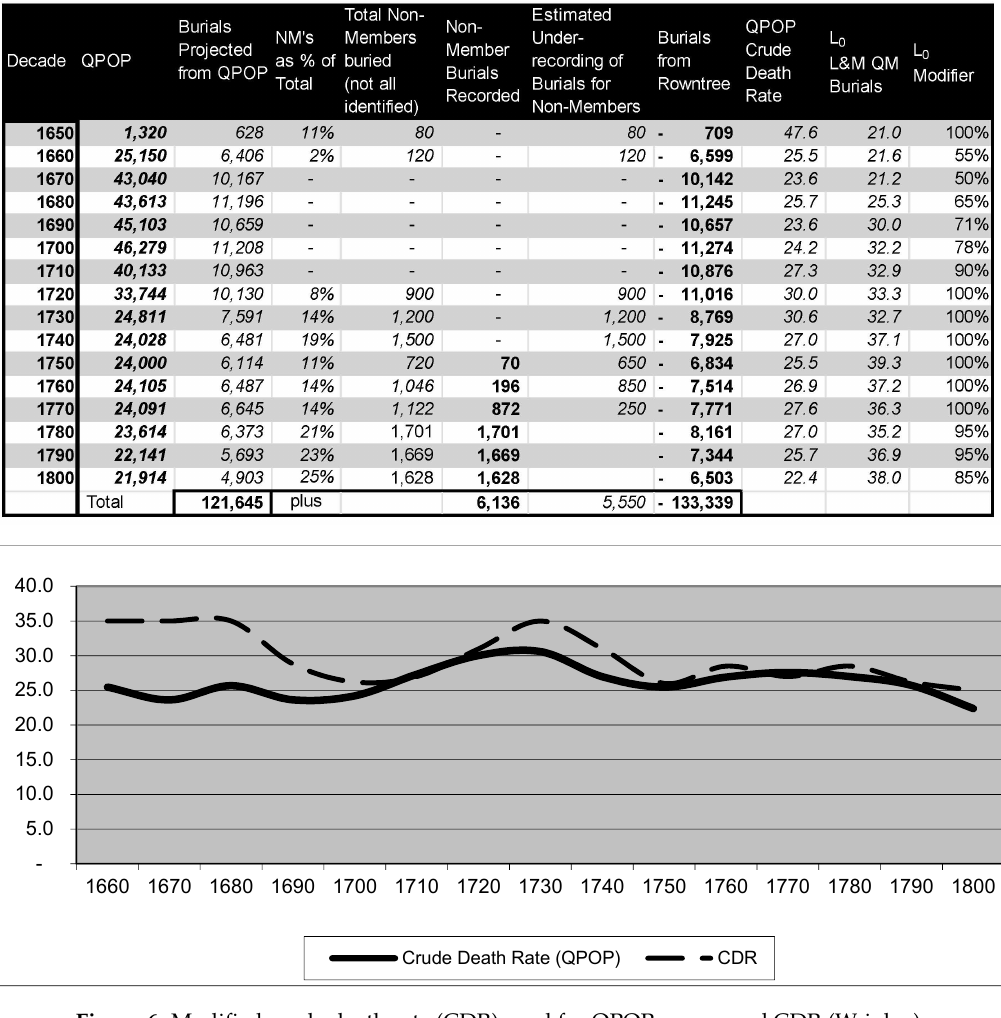
Table 3. Reconciliation of QPOP, crude death rate and QM burial registers by decade (1650–1809).